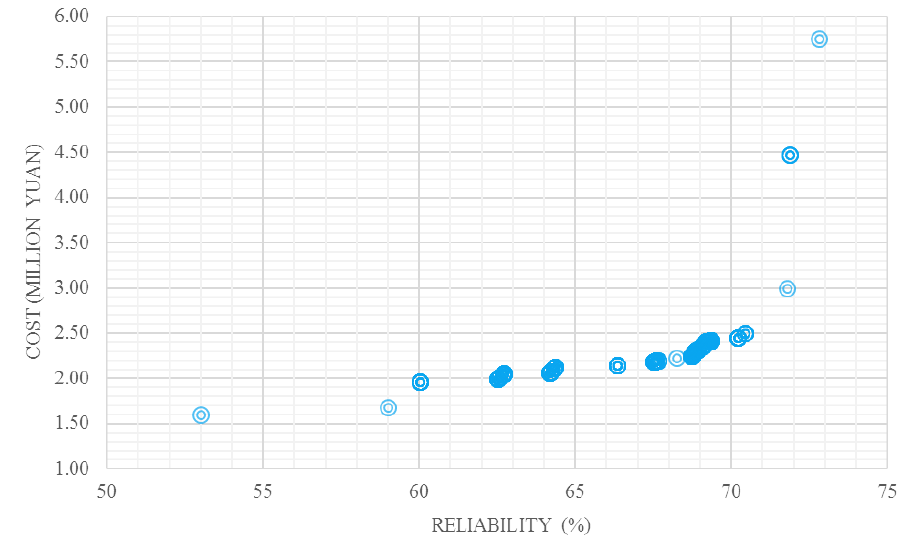
Figure 3. The optimal Pareto front for the case